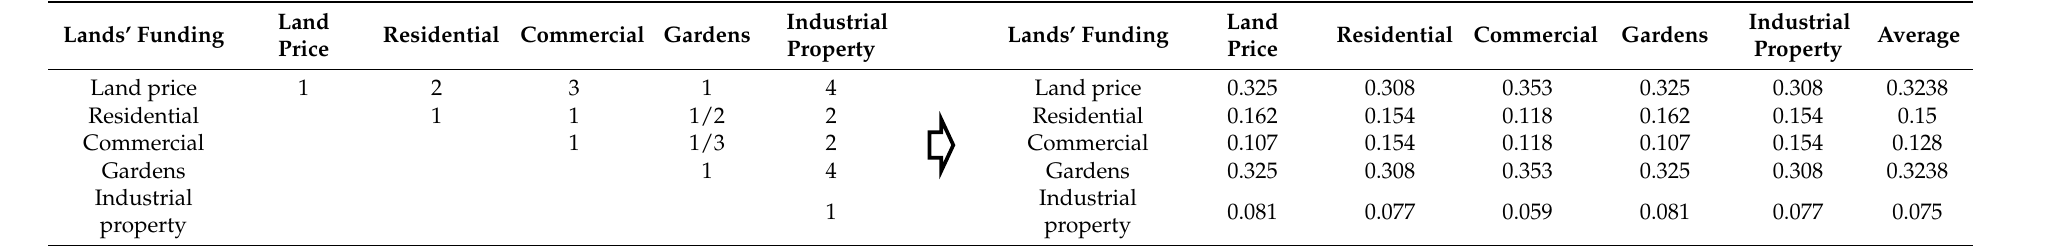
Table 4. The pairwise comparisons matrix for lands’ funding.